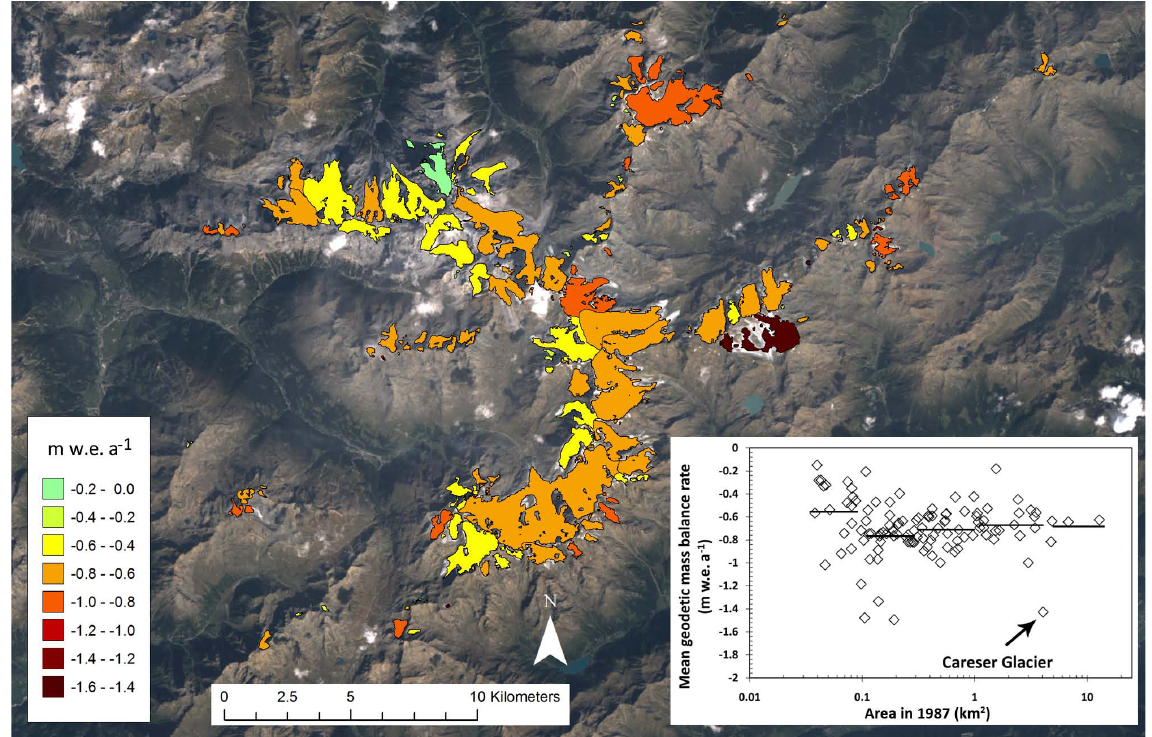
Fig. 10. Glacier specific mean geodetic mass balance rates calculated from the values shown in Fig. 9. The scatterplot shows the values plotted vs. initial area in